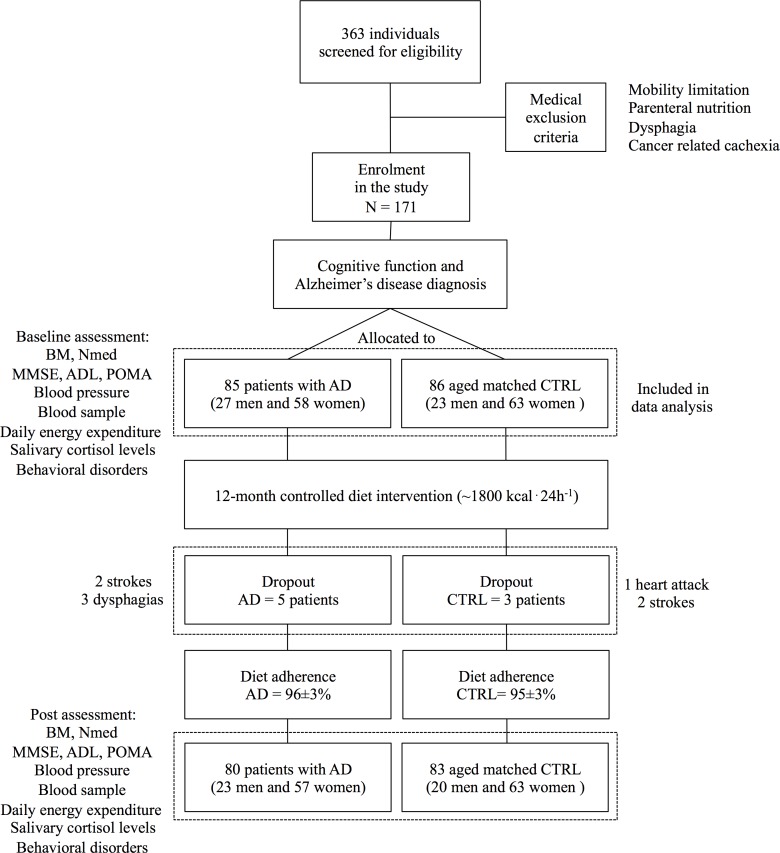
Participant flow diagram.AD, Alzheimer’s disease; CTRL, controls; BM, body mass; Nmed, number of medications; MMSE, Mini-Mental State Examination; ADL, activities of daily life; POMA; performance-oriented assessment of mobility.